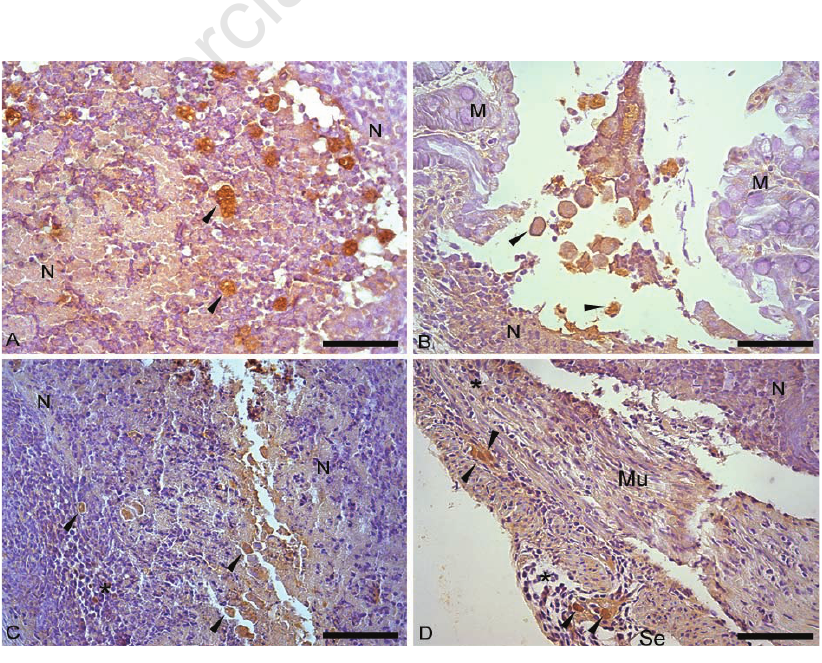
Figure 4. Immunohistochemical reaction for Entamoeba histolytica trophozoites. A) Liver parenchyma of hamster with large numbers of trophozoites (arrowheads) used as positive control of immunohistochemical reaction for trophozoites, necrosis (N); B) Entamoeba- wild type group: positive trophozoites (arrowheads) in erosion surrounded by well pre- served caecal mucosa. Necrosis (N) in the submucosa; C) Entamoeba-CD1 -/- group: exten- sive necrosis (N) with high number of trophozoites (arrowheads) and inflammatory infil- trate (*); D) Entamoeba-CD1 -/- group: trophozoites (arrowheads) in the serosa. Necrosis (N) in the submucosa and inflammatory infiltrate (*) in muscular and serosal layers. Bar = 30 µm. M, mucosa; Mu, muscular; Se; serosa; S,